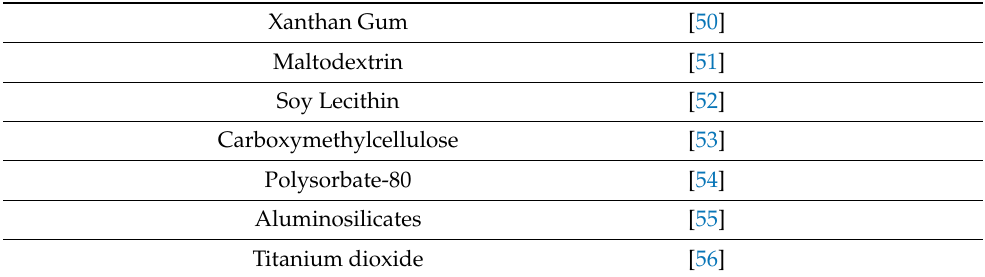
Table 3. Most common food additives consumed by a population of 138 children with Crohn’s disease